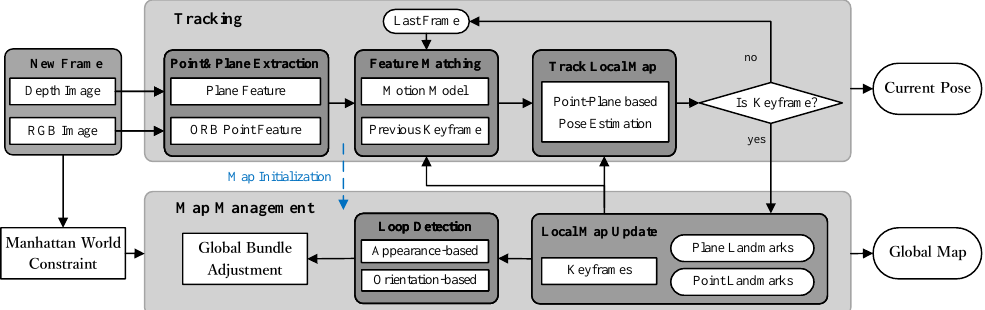
Figure 1. Overview of our point–plane-based RGB-D SLAM system. The inputs of the system are the RGB and depth images, and it can output the camera pose and scene’s map. We estimate the camera poses by using the tracked point and plane features. We exploit the point and plane constraints to update the local and global maps. The MW constraint is added to the map management part if the global MW axes are extracted from the first captured RGB-D